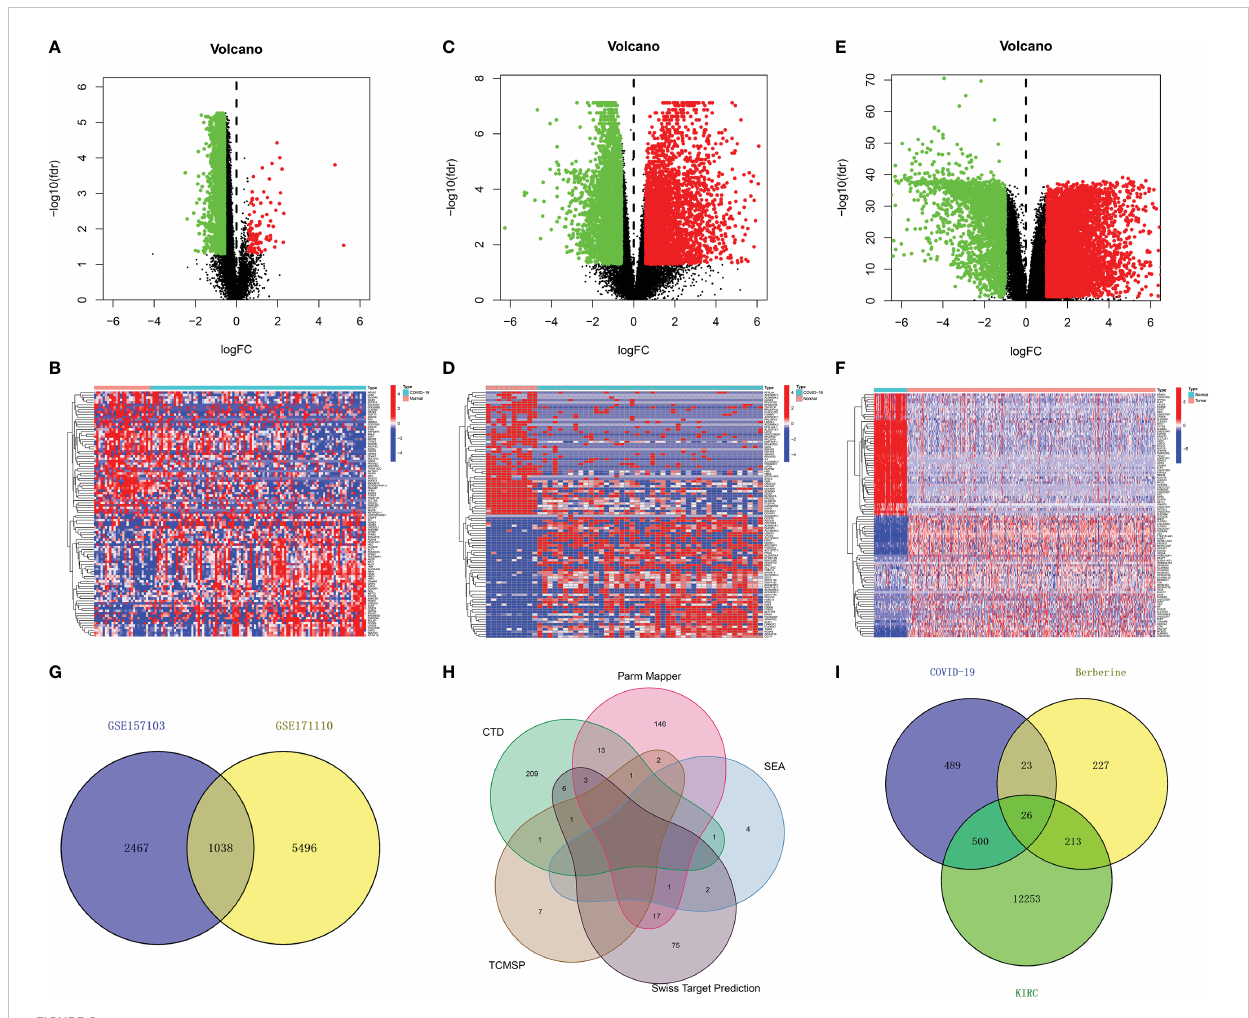
FIGURE 2 Identi fi cation of therapeutic target genes of berberine against KIRC/COVID-19. (A, B) Volcano plot and heatmap of DEGs from GSE157103 data set, and heatmap shown the top 50 DEGs (C, D) DEGs from GSE171110 data set. (E, F) DEGs from TCGA data set. (G) The intersection of GSE157103 and GSE171110 data set. (H) The union set of berberine target genes of each website. (I) The intersection of COVID-19 DEGs, KIRC DEGs and berberine target